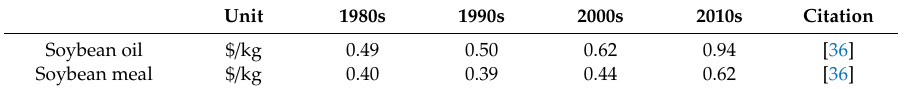
Table 5. Average sales prices of products from the soybean oil extruding-expelling process